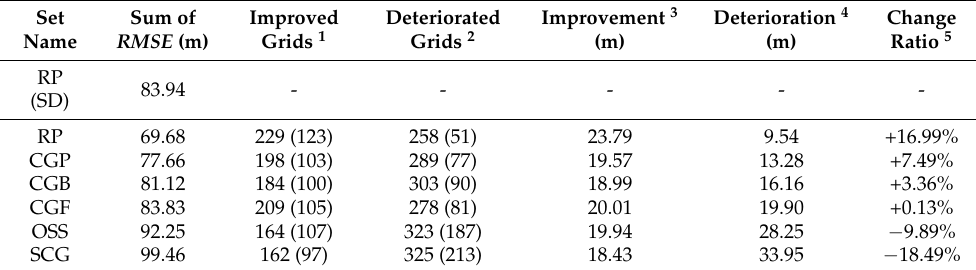
Table 2. Statistics of the RMSE difference map for ANN on real events. Only the benchmark ANN, RP (SD), was trained with the synthetic database. Other ANN were trained with the hybrid database. Set